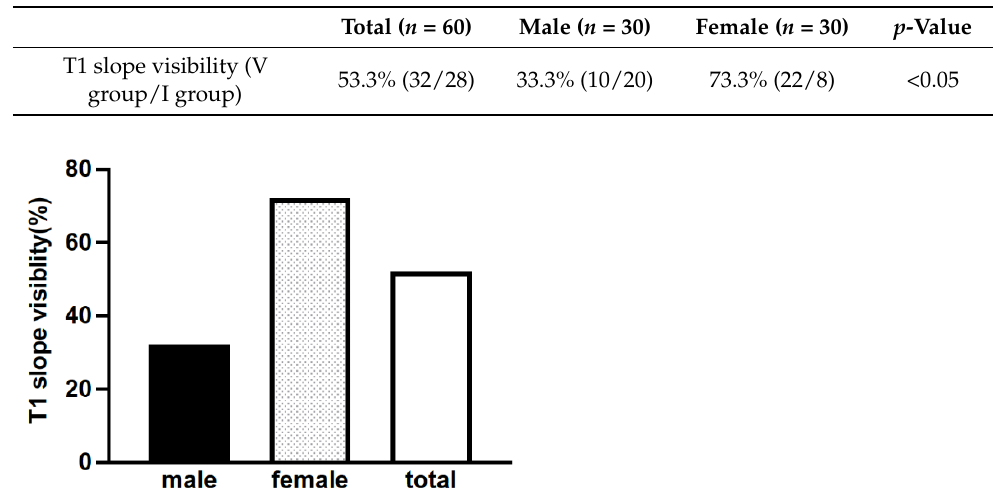
Table 1. T1 slope visibility.